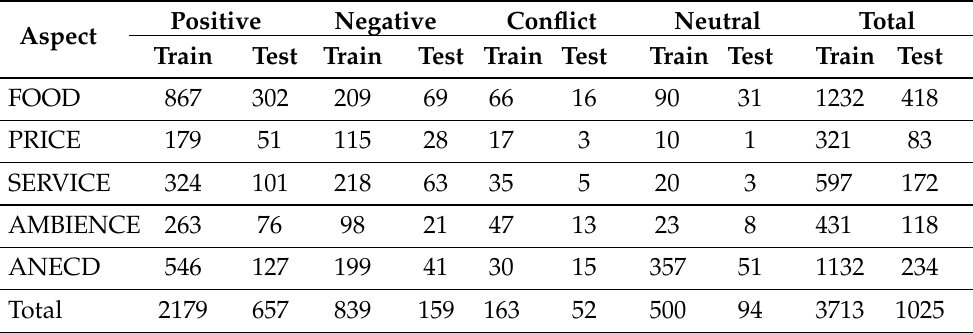
Table 2. Aspect categories distribution per sentiment